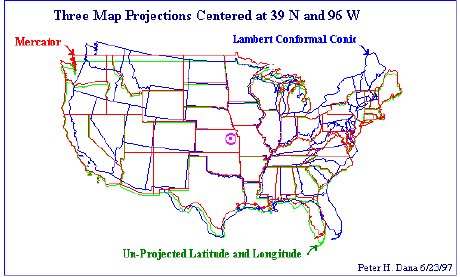
Fig. 2. A map showing the differences in the shape of an area of the US in various cartographical projections (source: http://www.colorado.edu/geog -